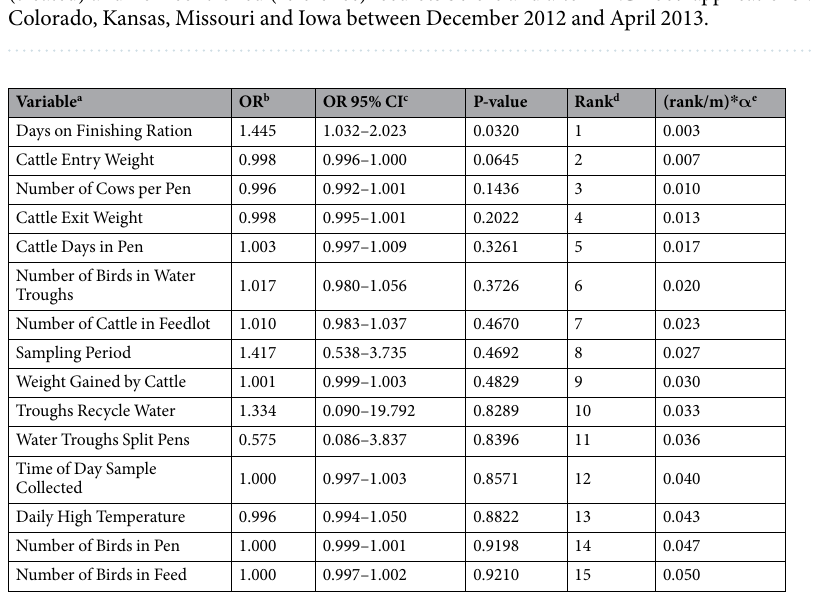
Table 3. Odds ratios, confidence intervals for odds ratios, P-values, P-value rank, and calculated Benjamini Hochberg cutoff values for significance of univariable models examining the odds of a fecal pat from cattle in commercial feedlots testing positive for ciprofloxacin-resistant Escherichia coli and independent variables related to starling population, pen, and feedlot characteristics. a Analyses of variables potentially associated with ciprofloxacin-resistant Escherichia coli contamination of cattle feed samples b Odds ratios for variables potentially associated with ciprofloxacin-resistant Escherichia coli fecal shedding by cattle. c 95% confidence intervals for odds ratios of potential explanatory variables associated with ciprofloxacin-resistant Escherichia coli fecal shedding by cattle. d Rank order of p-values from analyses of potential explanatory variables associated with ciprofloxacin-resistant Escherichia coli fecal shedding by cattle. e Benjamini Hochberg cutoff values for rejection of null hypotheses. Based on these cutoff values, we failed to reject null hypotheses for all univariable analyses assessing ciprofloxacin-resistant Escherichia coli fecal shedding by